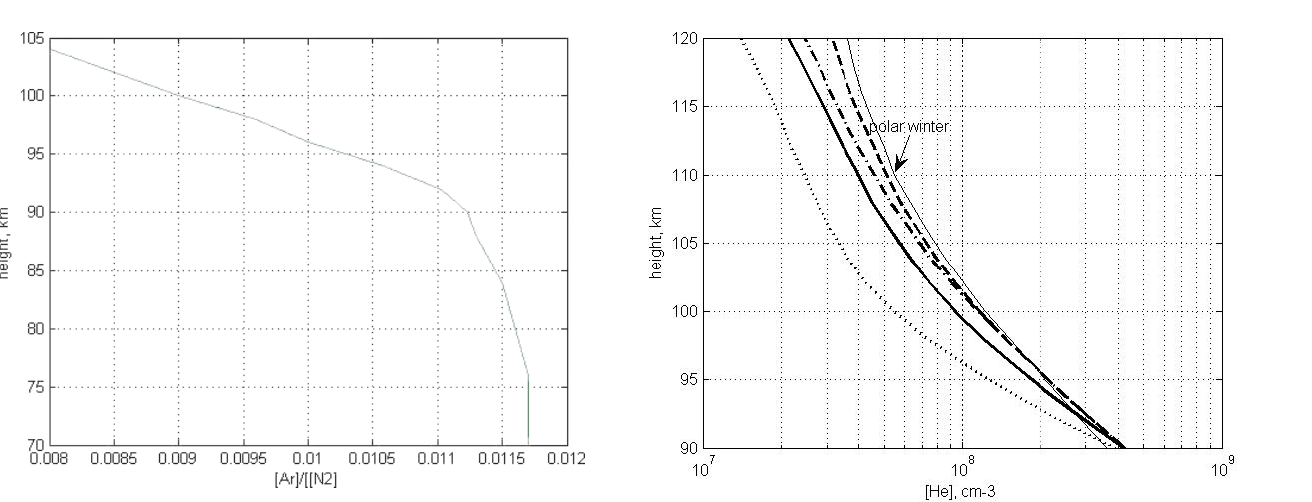
Fig. 3. [He] height profiles according to the MSIS-E-90 model: win- ter solstice at 40 ◦ N latitude at 14:00LT (dashed curve), summer solstice at 40 ◦ N latitude at 14:00LT (solid curve), the summer sol- stice at the equator at the same local time (dashed-dotted curve), and polar summer solstice at 70 ◦ N latitude (dotted curve), the lon- gitude of 0 ◦ for all data. All eddy diffusion coefficients are inferred from the MSIS-E-90 data, and the cooling rates corresponding to these coefficients are presented for the above given